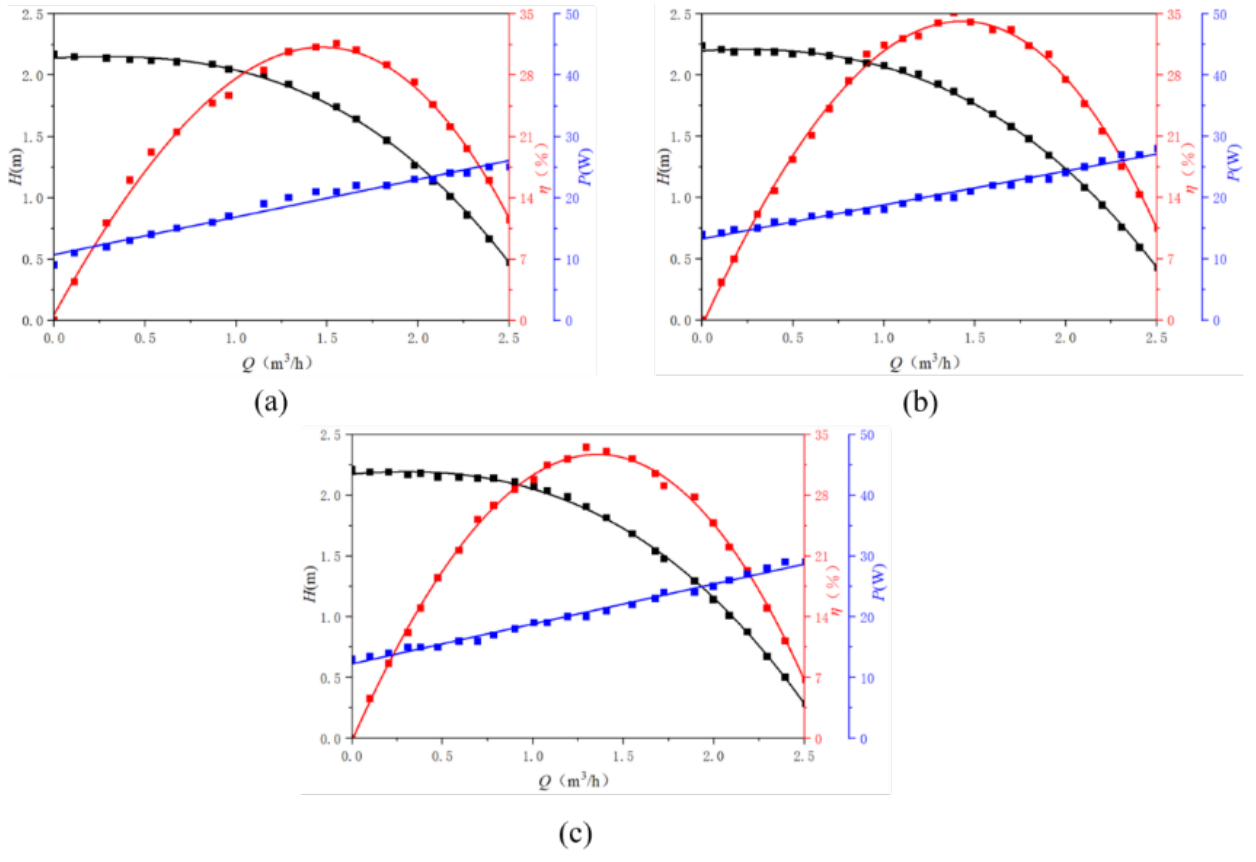
Figure 3. Experimental performances of different model pumps: ( a ) OTE; ( b ) ATE1; and ( c ) ATE2. The PIV experiments of ATE1 and ATE2 at the flow rate conditions of 0.2 Q BEP , 0.4 Q BEP , 1.0 Q BEP , and 1.2 Q BEP are investigated based on the nominal efficiency flow rate of OTE pump (i.e.,1.0 Q BEP = 1.52 m 3 /h). Subsequently, the influence of blade trailing edge